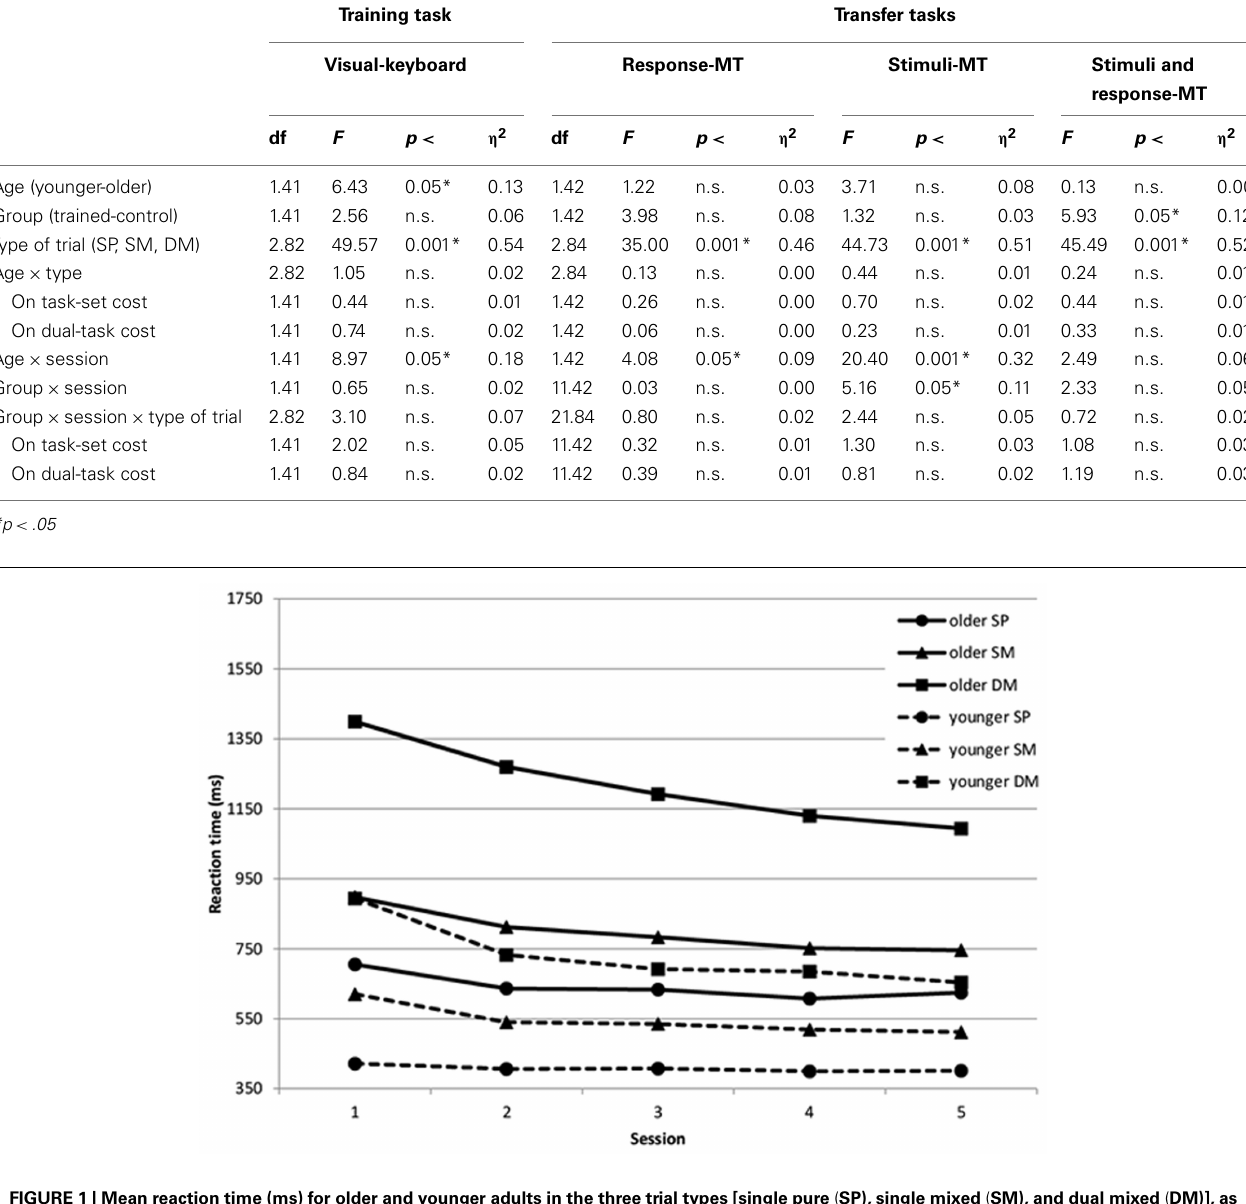
PRE VS. POST-TRAINING